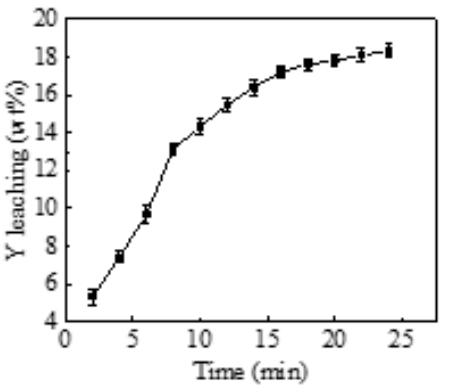
Figure 4. The effects of mechanical activating time on leaching efficiency (T = 80 °C).